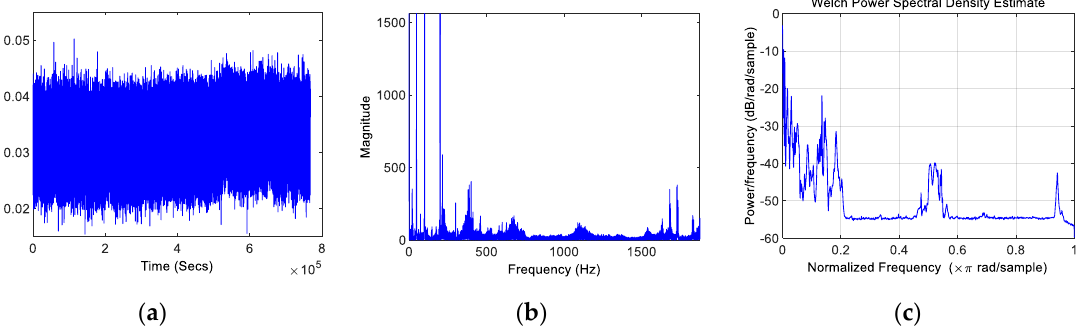
Figure 7. Comparing time-domain vibration data with frequency domain. ( a ) Time domain vibration data; ( b ) fast Fourier transform (FFT, magnitude) of vibration data; ( c ) power spectral density (PSD) of vibration data.